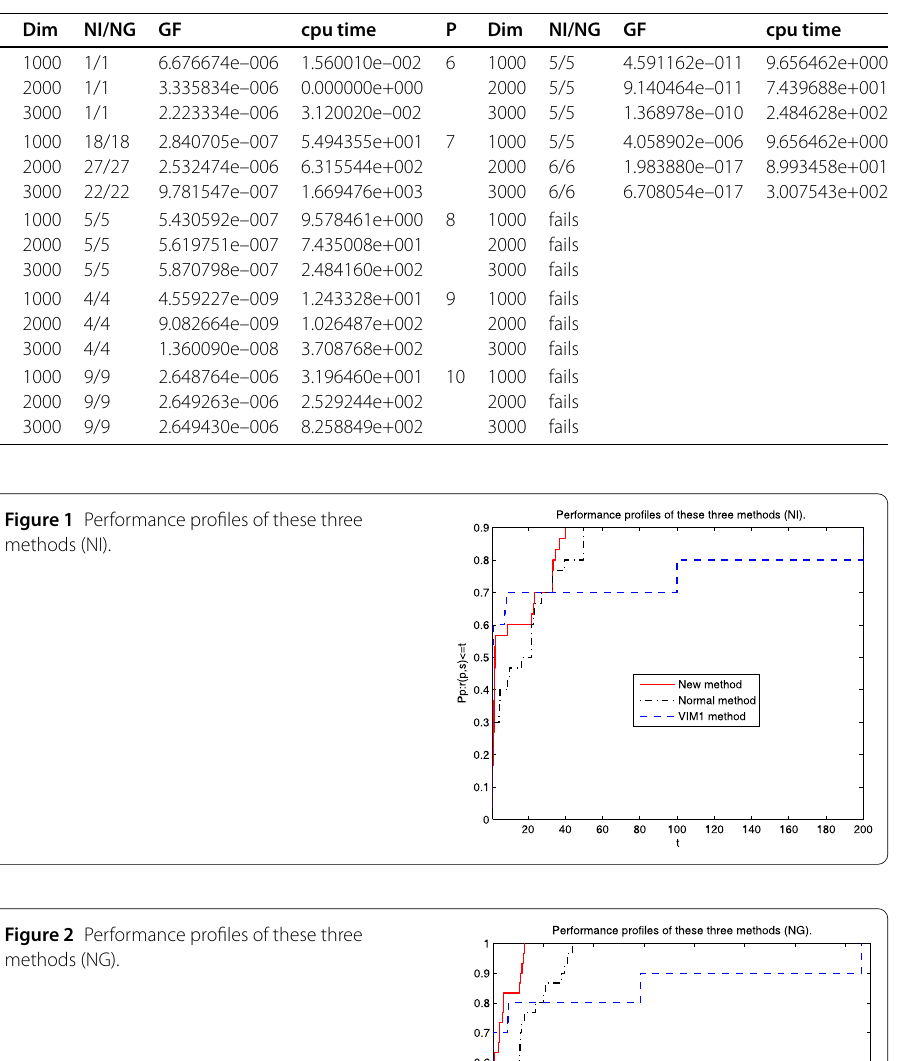
Table 2 Numerical results of VIM1